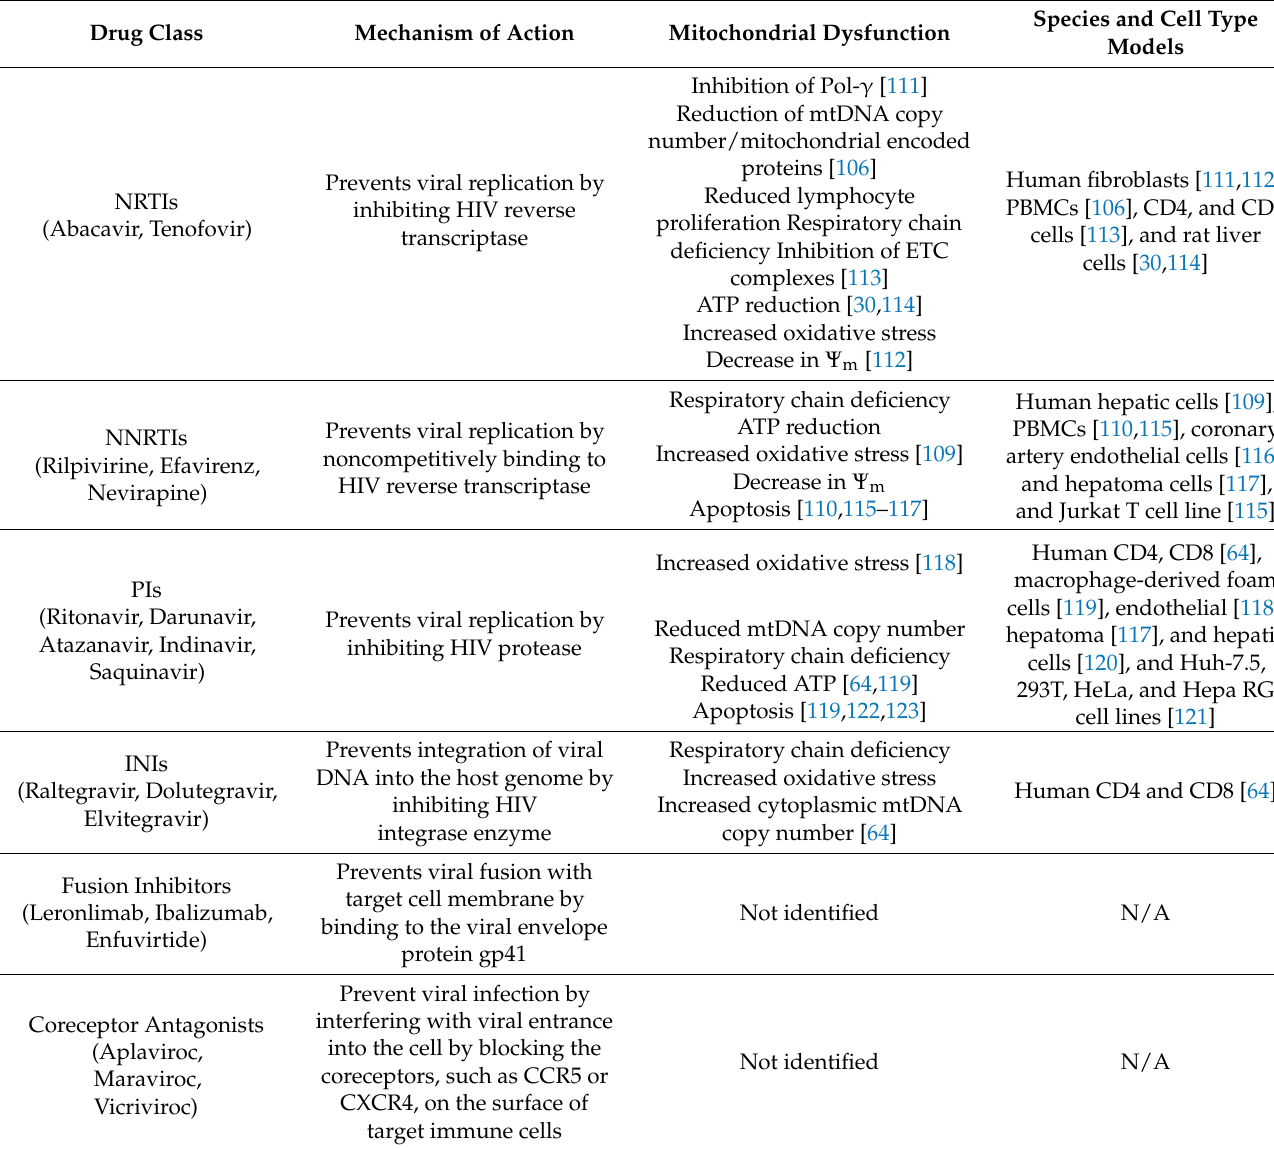
Table 1. Pharmacology of antiretroviral therapy and reported effect on mitochondria